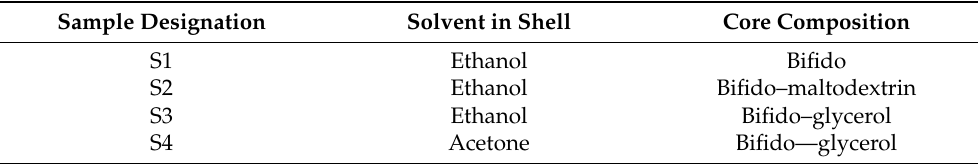
Table 1. Sample designation for the different core–shell microcapsules made of ethyl cellulose in the